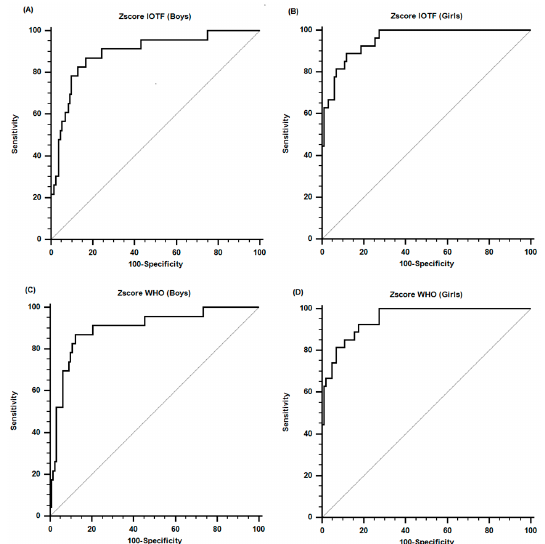
Figure 2. ROC curves of Z-scores of IOTF: ( A ) Boys; ( B ) Girl and WHO: ( C ) Boys; ( D ) Girl that showed the highest sensitivity and specificity when used in Chilean children and adolescents, using the cutoffs of the fat mass percentage values measured by DXA as criteria.